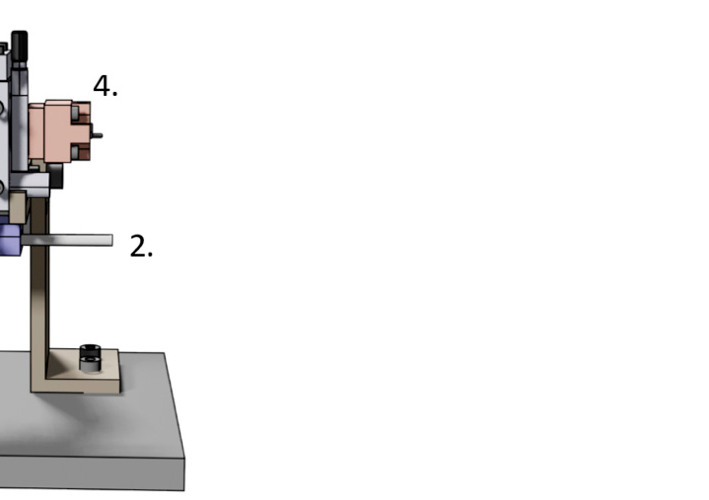
Figure 3. Dedicated nanomotion detection apparatus. 1. analysis chamber with the AFM cantilever, 2. inlet, 3. outlet, 4. laser inlet, 5. prisms to orient the laser beam onto the cantilever and the photodiodes, 6. photodiodes.